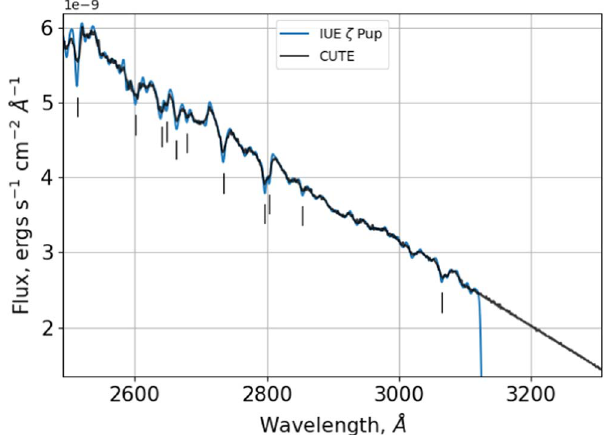
Figure 7. Flux-calibrated spectrum of ζ Pup. A CUTE spectrum is in black, plotted over the blue IUE spectrum. Black vertical tick marks note the spectral features used to calculate CUTE ʼ s wavelength solution. IUE sensitivity falls off beyond 3100 Å , so a model was fi t to the IUE data in order to calculate CUTE ʼ s effective area and fl ux spectrum.